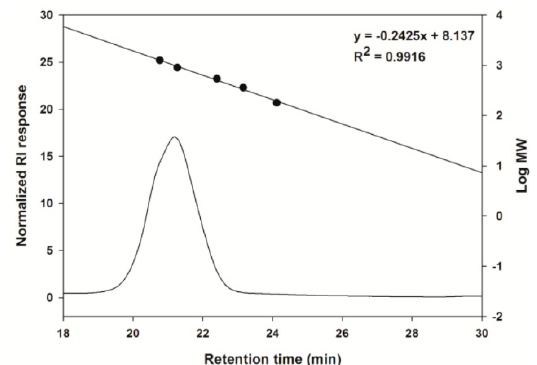
Figure 2. Size exclusion high-performance liquid chromatography (HPLC) chromatogram of the major CCK-oligosaccharides.